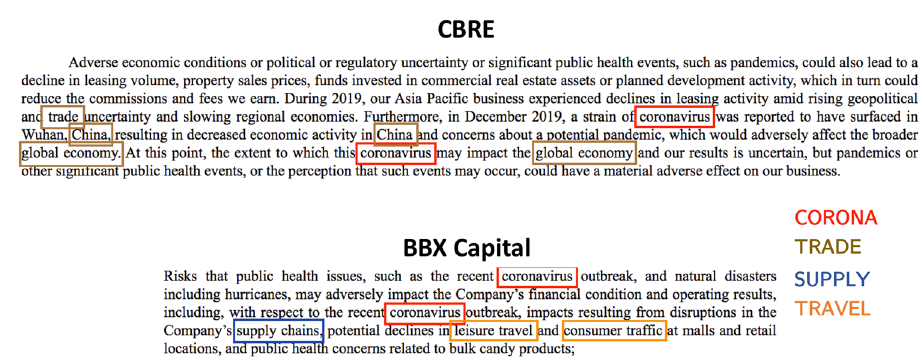
Fig. 4 Examples of paragraphs in 10-K reports that mention the term ‘ coronavirus ’ and other business-speci fi